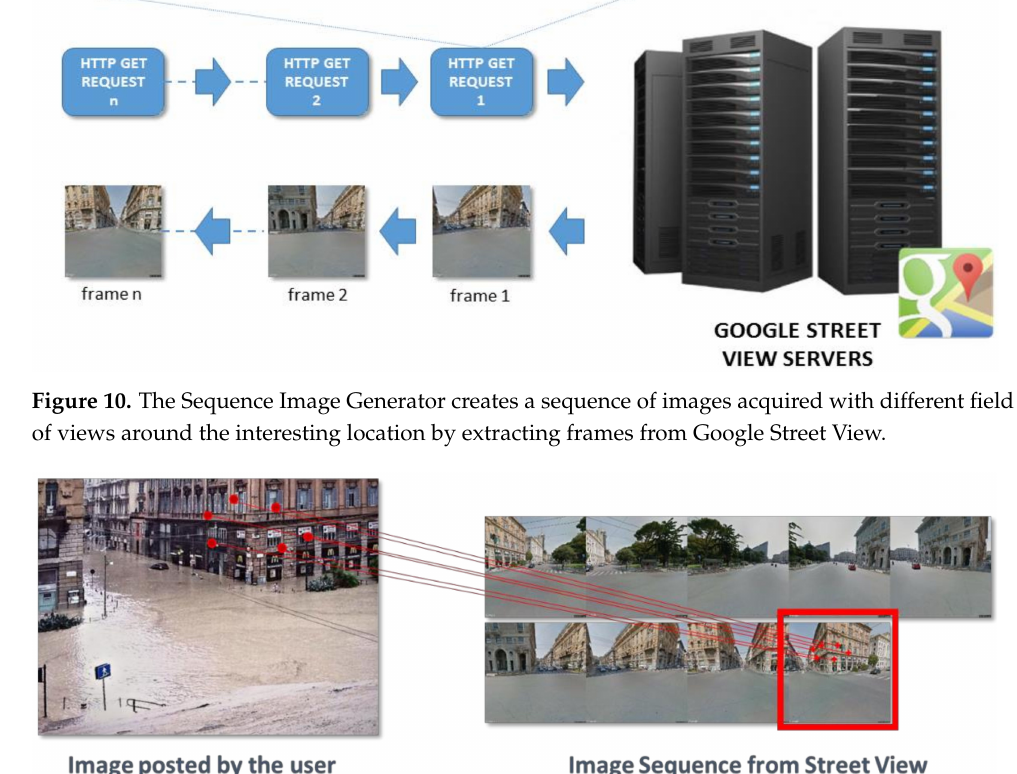
Figure 11. An example of the matching procedure between the image posted by the user and the image sequence extracted from Street